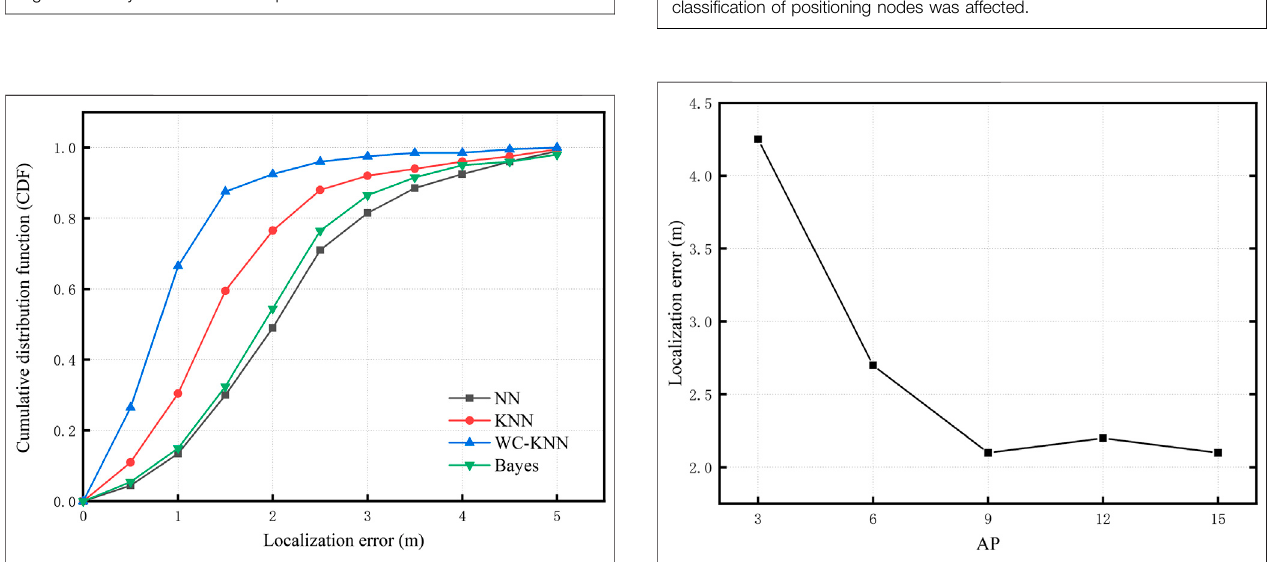
FIGURE 4 | Blue line was a path which generate randomly. It was selected as the real path. Red line was a path which is predicted by WC-KNN algorithm. They all contained 100 points.